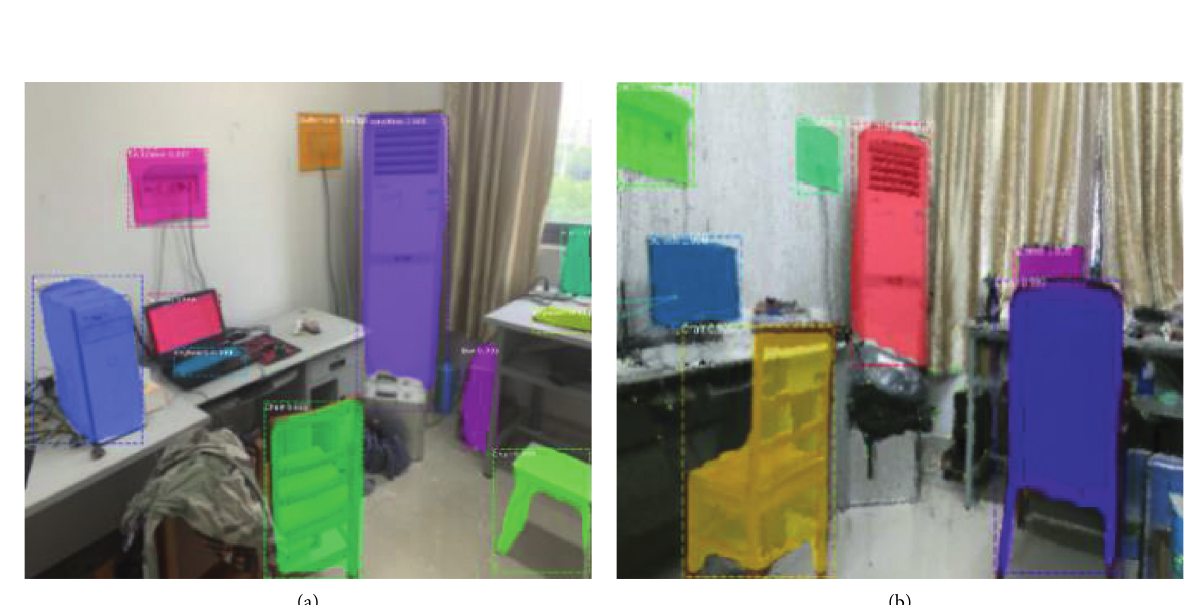
Figure 7: Effect image of target detection and recognition (a) and semantic map of dense point cloud